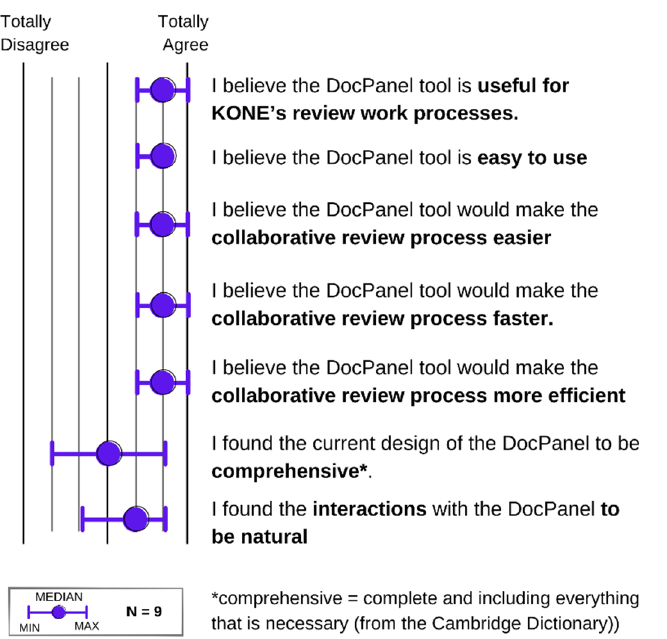
Figure 8. Expectations and experiences with VR platform. A seven-point Likert scale was used.